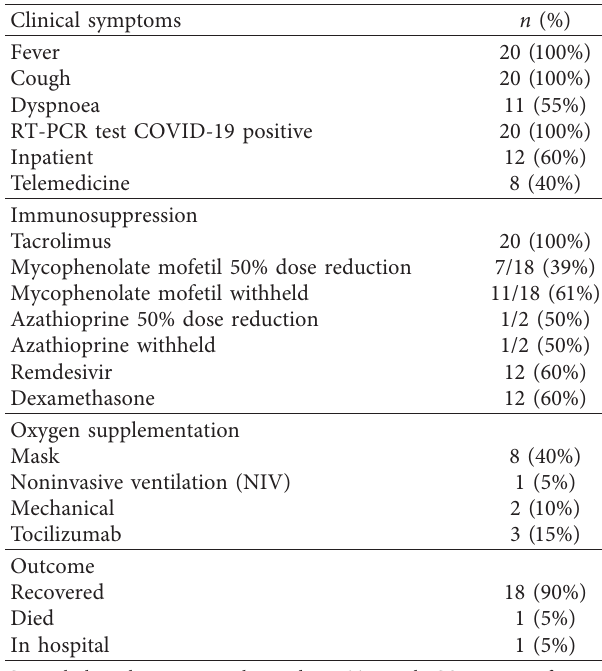
Table 1: Basic clinical profile of kidney transplant recipients with SARS-CoV-2